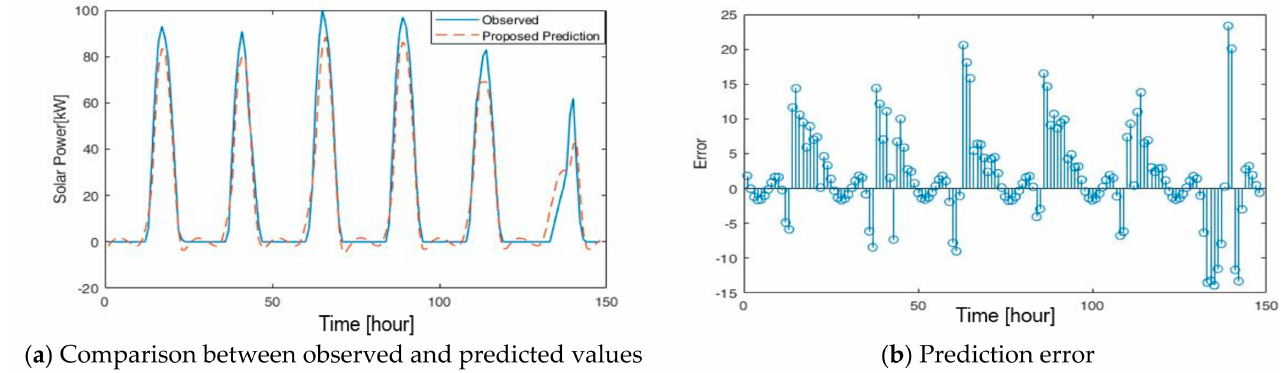
Figure 7. Solar power forecasting using the proposed